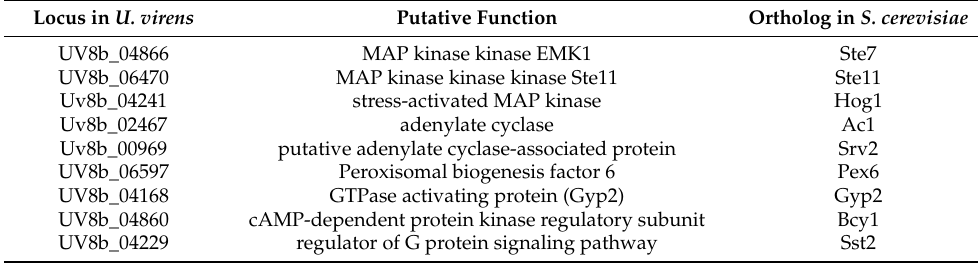
Table 1. UvSte50-interacting proteins identified by the affinity capture–mass spectrometry assay. Locus in U.